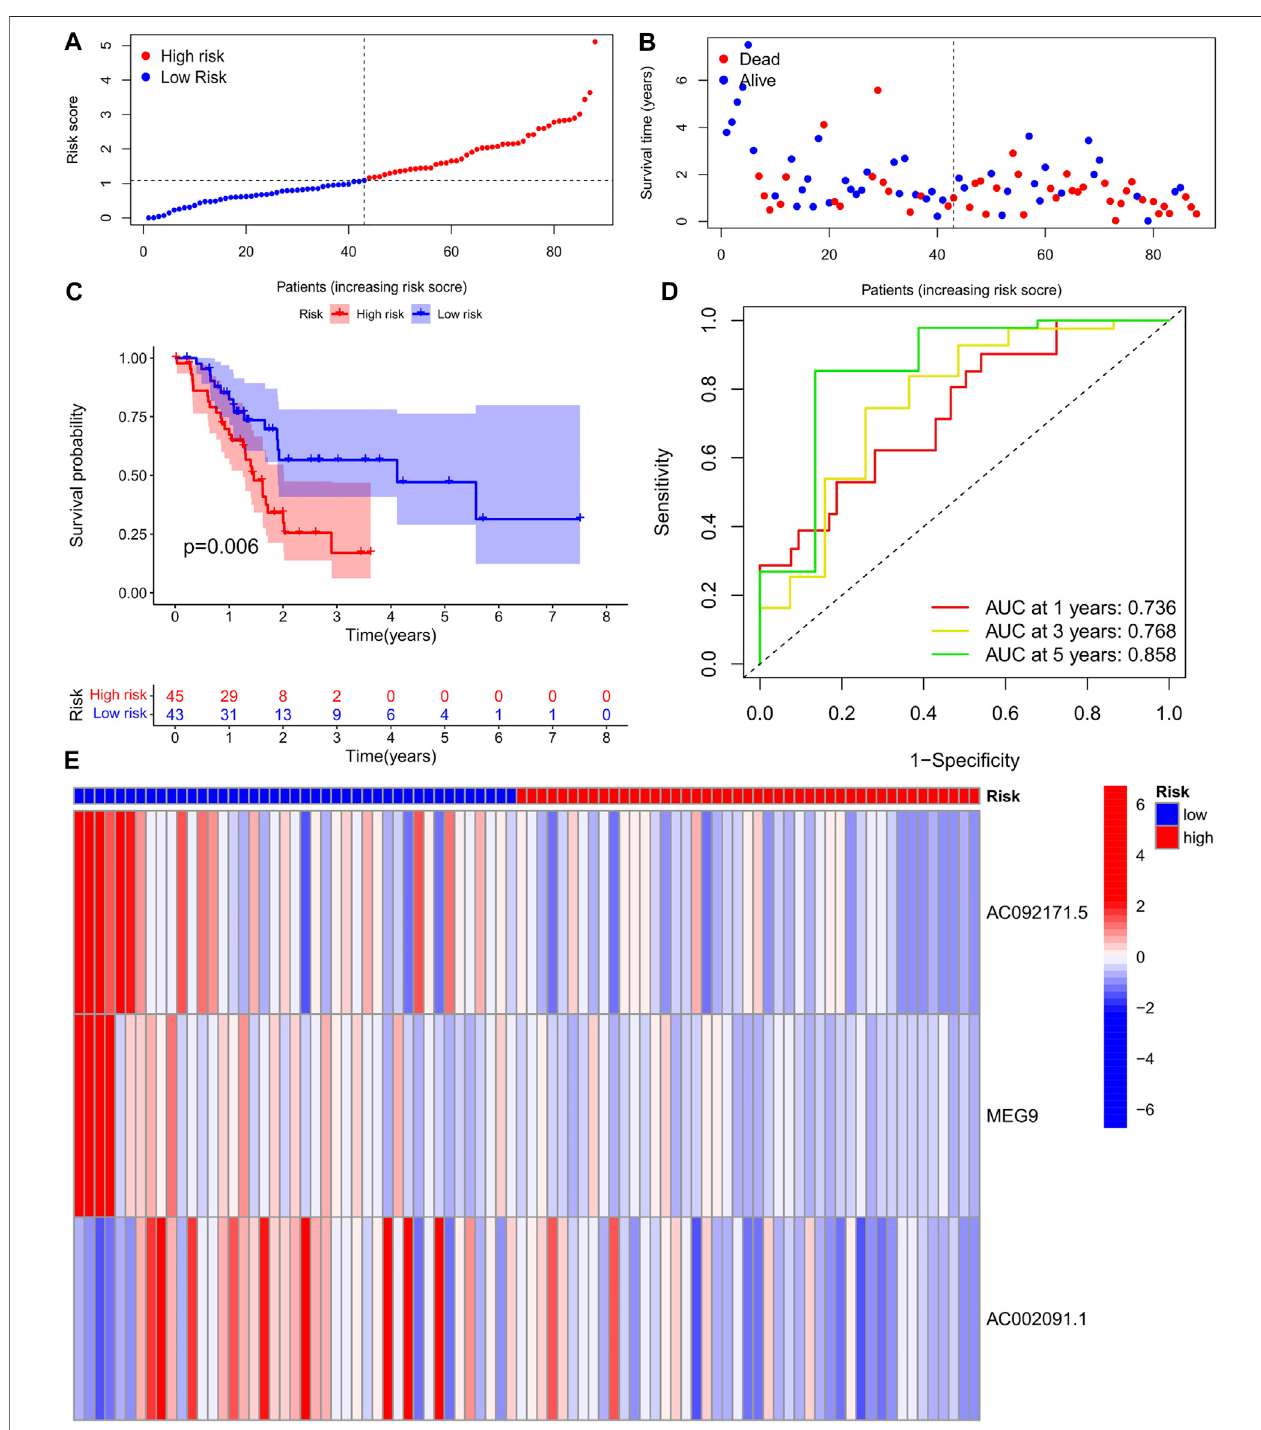
FIGURE 4 | (A) Survival status of patients in different groups in test cohort. (B) Rank of prognostic index and distribution of groups based on m6A-lncRNA prognostic signature risk scores in training cohort. (C) Survival status of patients in different groups in Test cohort. (D) Receiver operating characteristic (ROC) curves of the m6A-lncRNA prognostic signature for predicting the 1-year, 3-years, 5-years survival in Test cohort. (E) Heatmap of the m6A-lncRNA in Test cohort.